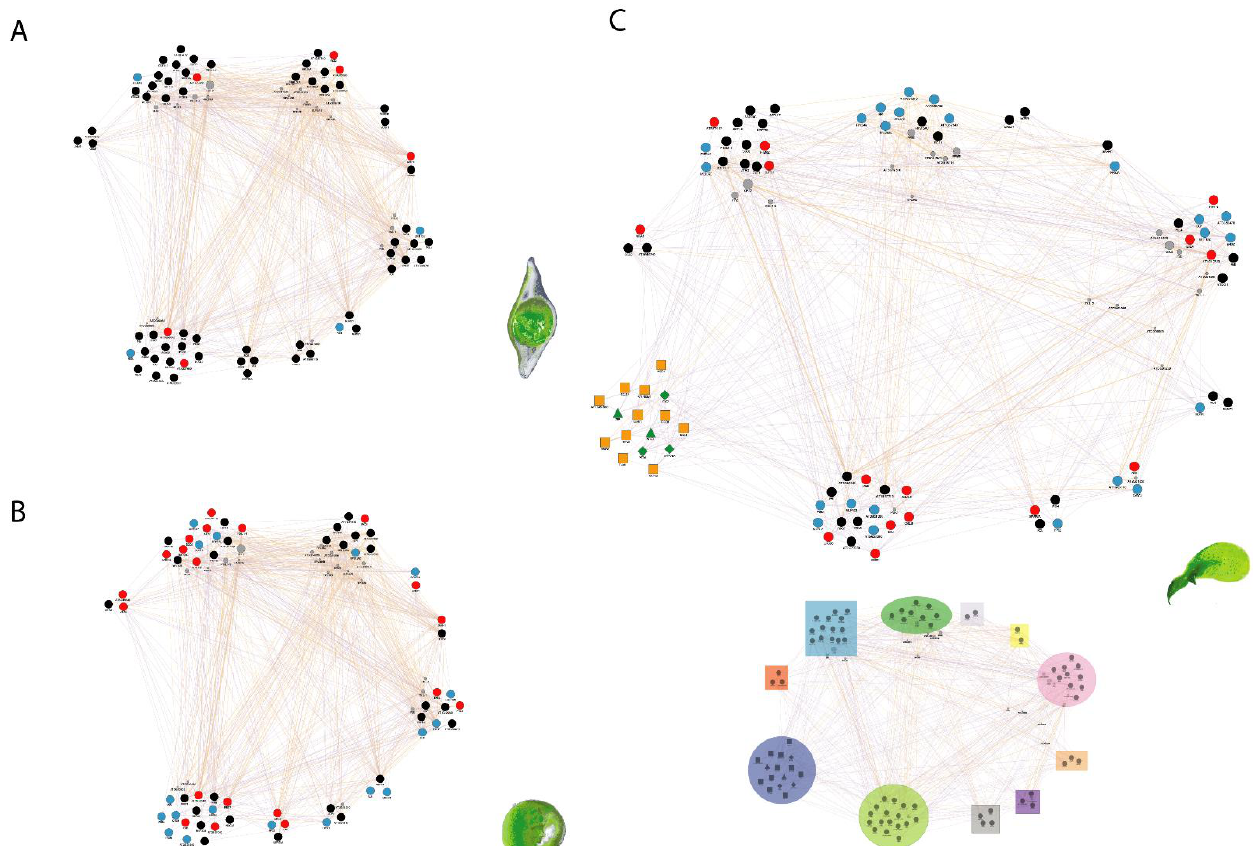
Figure 1. Network comparison between symbiotic germination (up-regulated) and asymbiotic germination (down-regulated) in three different developmental stages in Dendrobium officinale . The network was constructed using the differential expressed genes reported by Chen et al. [64] using the geneMANIA app (v3.5.2; [77]) in Cytoscape (v3.8.2; [78]) predicting the function on Arabidopsis gene sets using the information reported in Ronemus et al. [79] and Lee et al. [80]. ( A ) Stage 2: testa rupture (germination). ( B ) Stage 3: protomeristem appearance (protocorm). ( C ) Stage 4: emergence of the first leaf (seedling), at this stage we incorporate the phytohormonal regulation described by Wang et al. [76]. In the bottom left corner we present the color guide of the functional clustering: red, inorganic ion transport; blue, posttranslational modification; dark green, translation and ribosomal structure and biogenesis; lilac, lipid transport and metabolism; yellow, coenzyme transport and metabolism; pink, carbohydrate transport and metabolism; orange, nucleotide transport and metabolism; purple, amino acid transport and metabolism; gray, energy production and conversion; pale green, unknown/general function prediction; and dark blue, phytohormonal regulation (upregulated, orange, and downregulated, green; squares, SL regulators; triangles, JA regulators; and diamonds, ABA regulators).